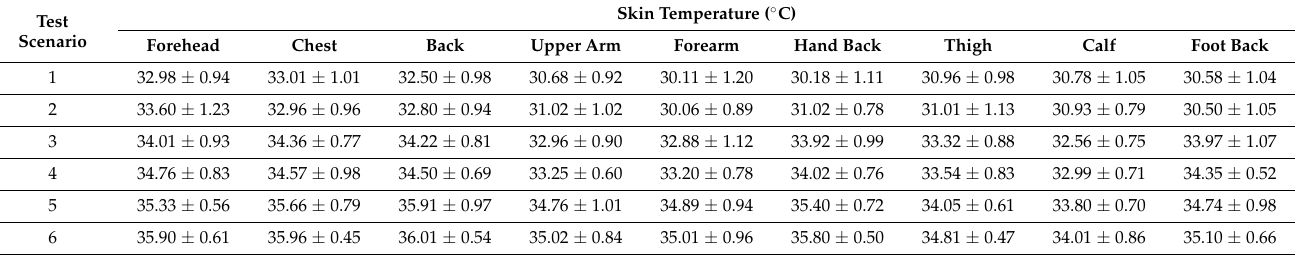
Table 3. Local skin temperature under different test scenarios.